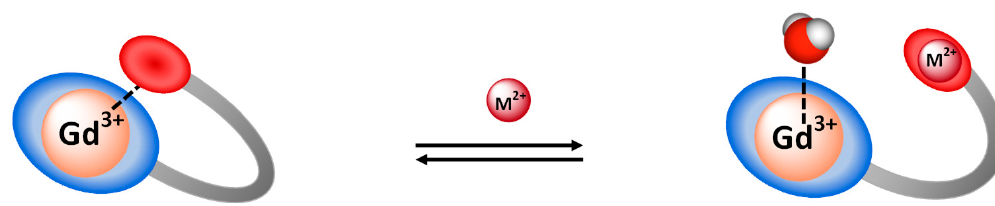
Figure 4. Principle of cation detection by q -modulation.